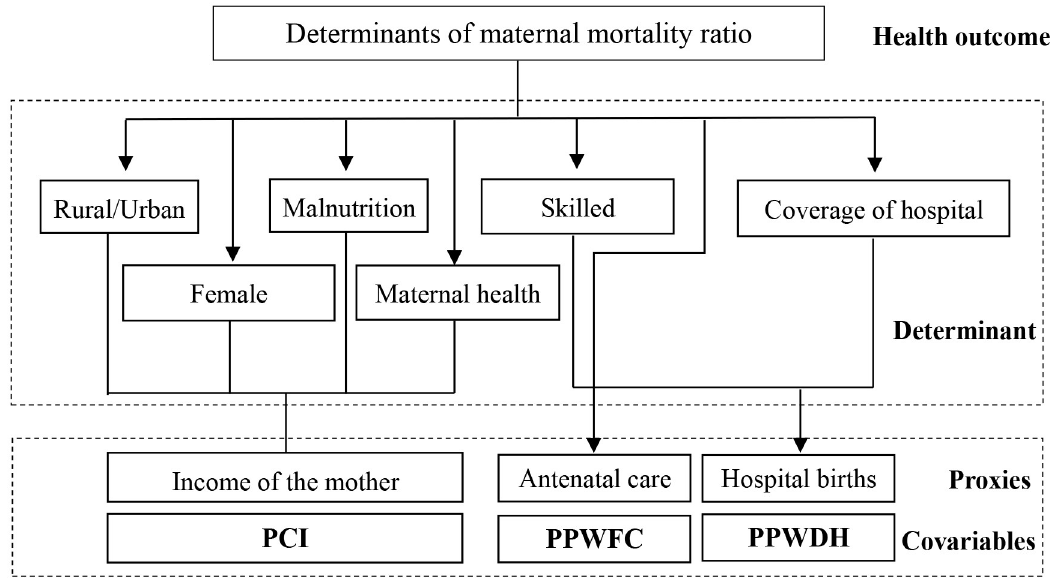
Fig 1. Nonmedical determinants (and their proxies) of the MMR. MMR, maternal mortality ratio; PCI, per capita income; PPWDH, proportion of pregnant women who delivered in hospitals; PPWFC, proportion of pregnant women who received 5 or more maternal